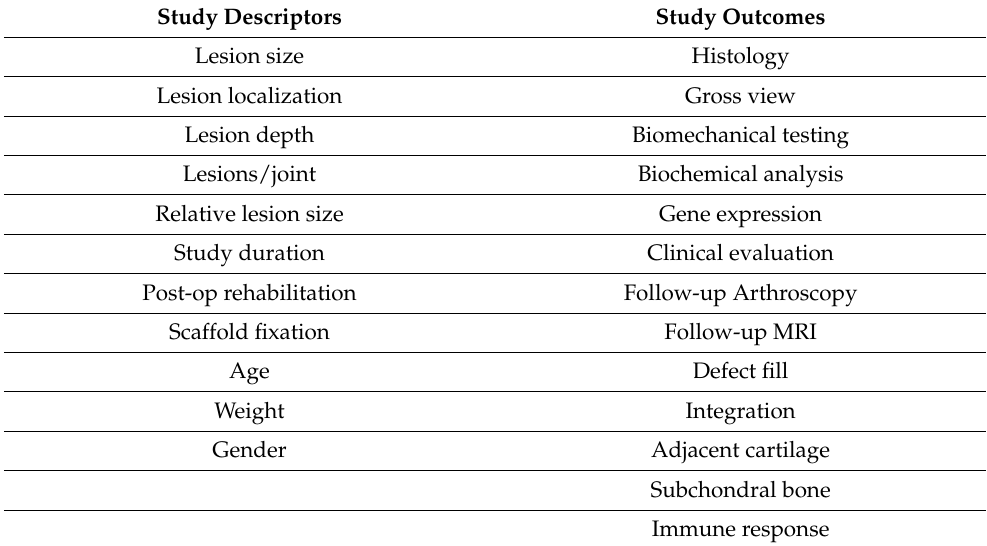
Table 1. List of 24 major aspects defined by the guidance documents.